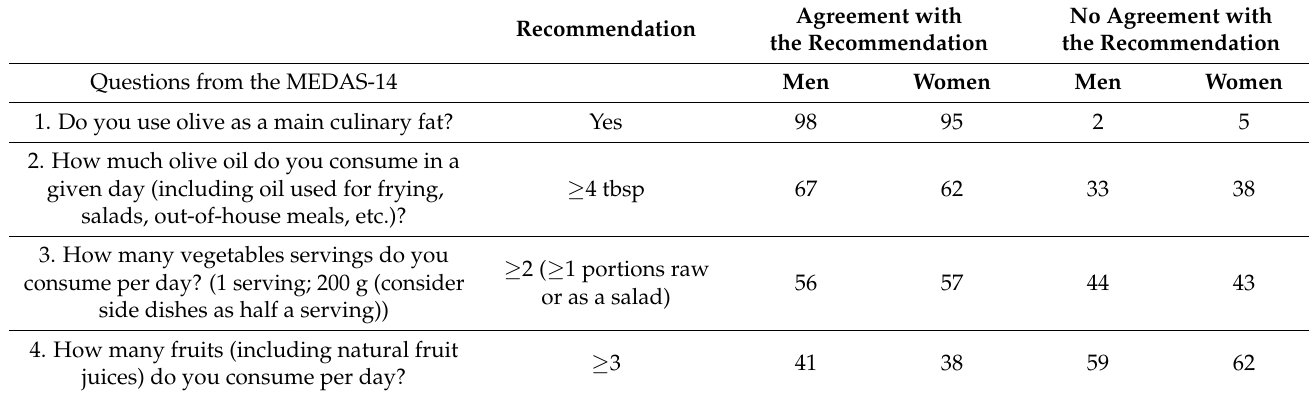
Table 2. Agreement with the recommendations based on each item of the Mediterranean Diet Adherence Screener (MEDAS-14 item score), by